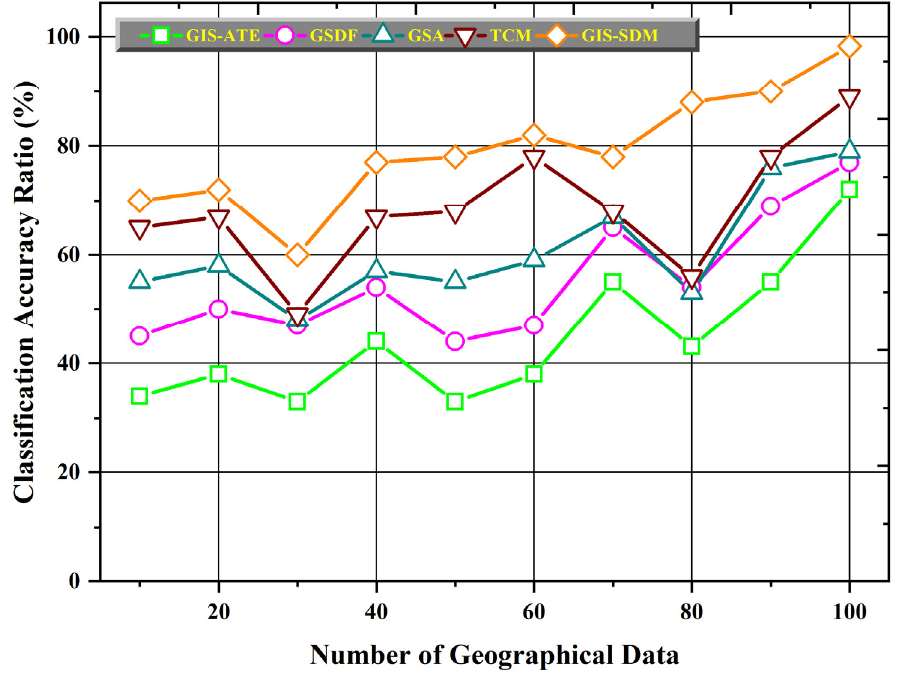
Figure 5. Classi fi cation accuracy